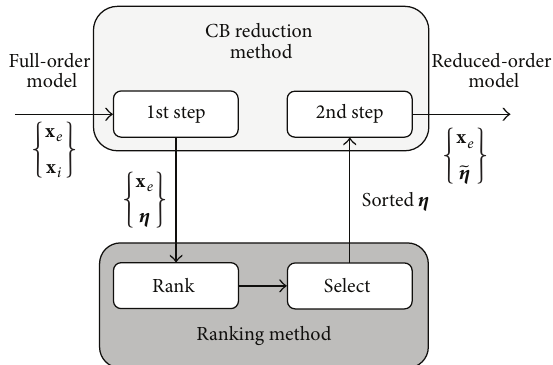
Figure 1: Schematic representation of the interaction between a ranking method and the Craig-Bampton